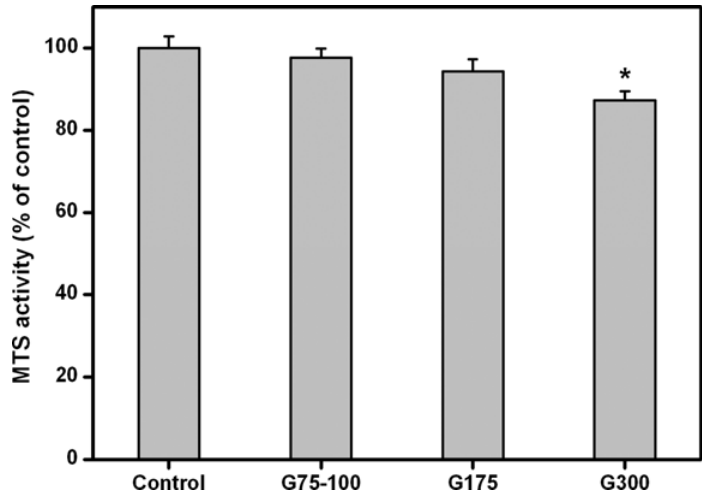
Figure 2. Cell proliferation assay of ARPE-19 cell cultures incubated in the presence of various dissolved gelatin materials for two days at 37